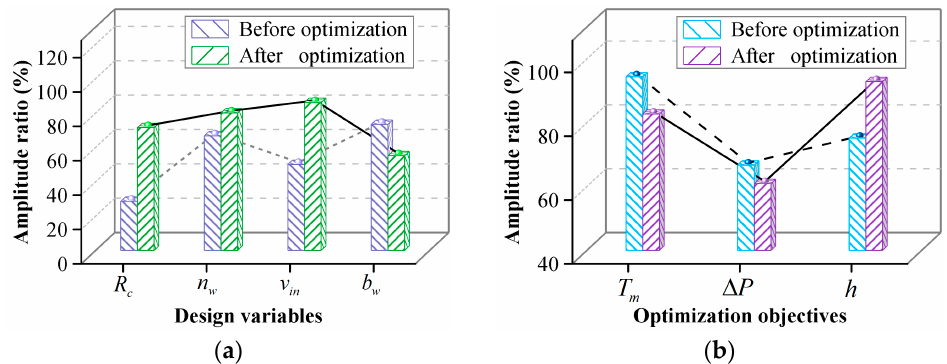
Figure 15. Comparison of initial scheme and optimal scheme: ( a ) Design variables; ( b ) Optimization targets.